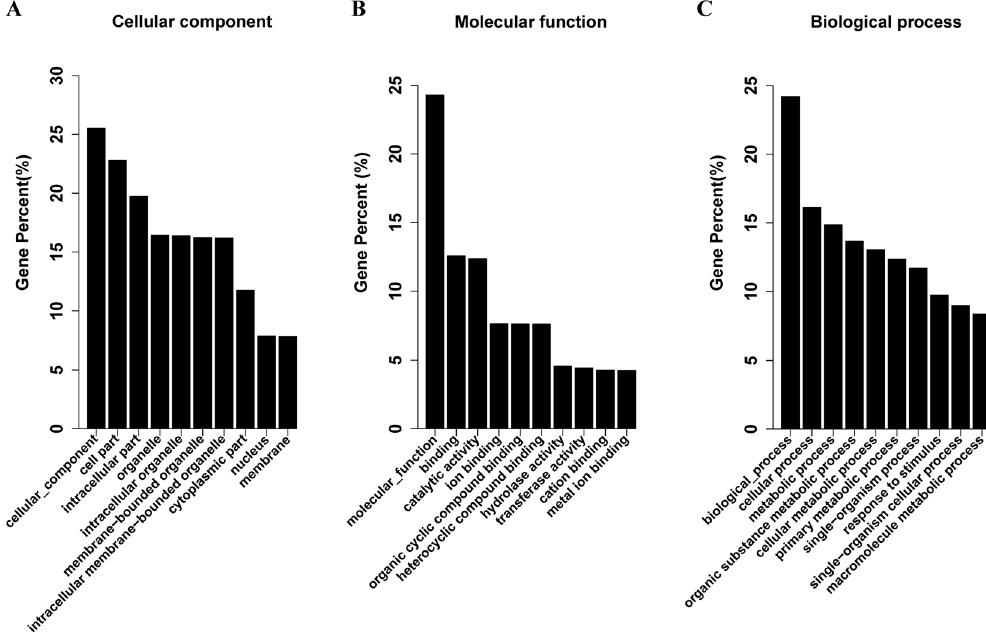
Figure 4. Gene ontology (GO) analysis of differentially expressed mRNAs under PVY infection in tobacco. ( A ) Category of cellular components; ( B ) Category of molecular functions; ( C ) Category of biological